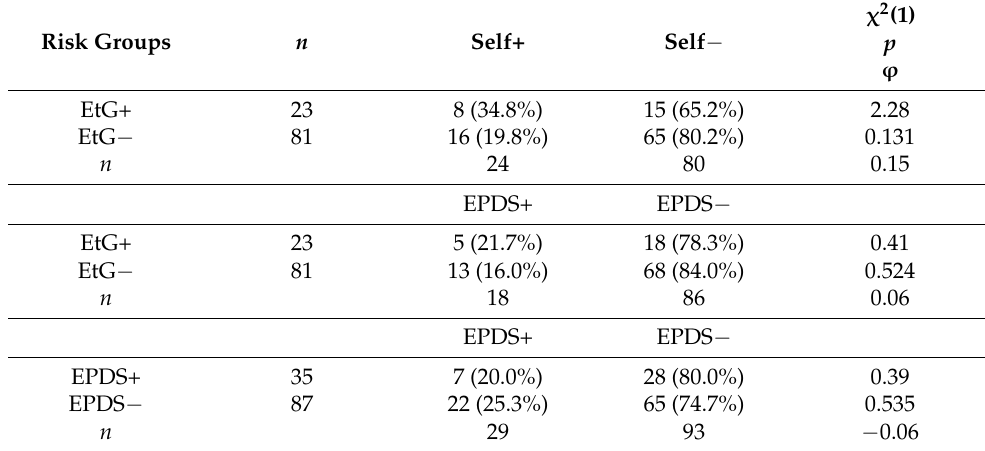
Table 3. Association between Self-Report, EtG, and